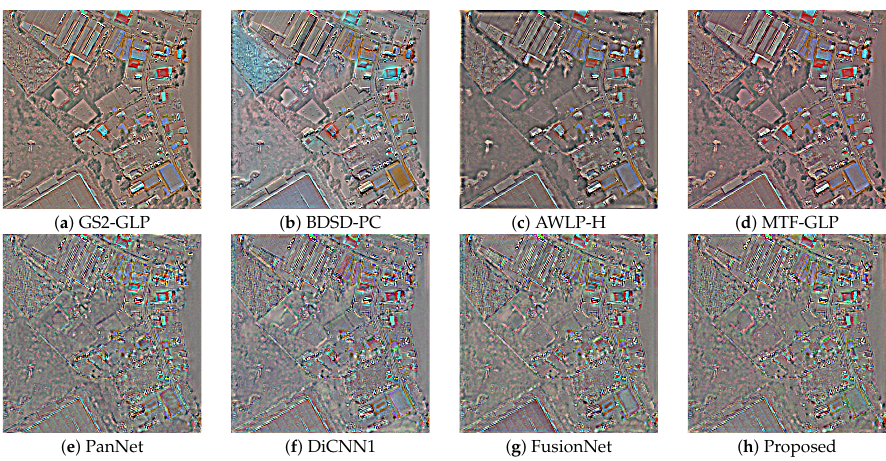
Figure 7. Residual images of fusion results shown in Figure 6. Table 8. Comparison of indicator evaluation results on the reduced-resolution WorldView-3